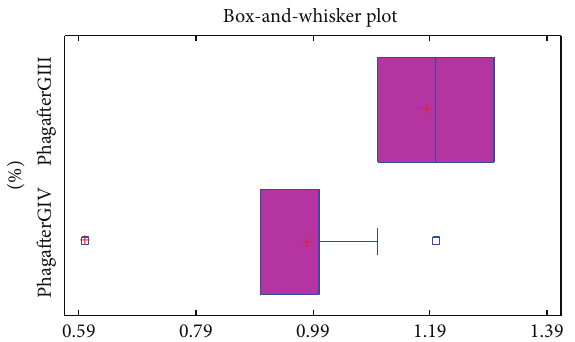
Figure 2: Values of phagocytizing platelets in patients of group III (%phagafterGIII) and group IV (%phagafterGIV) patients deter- mined following the